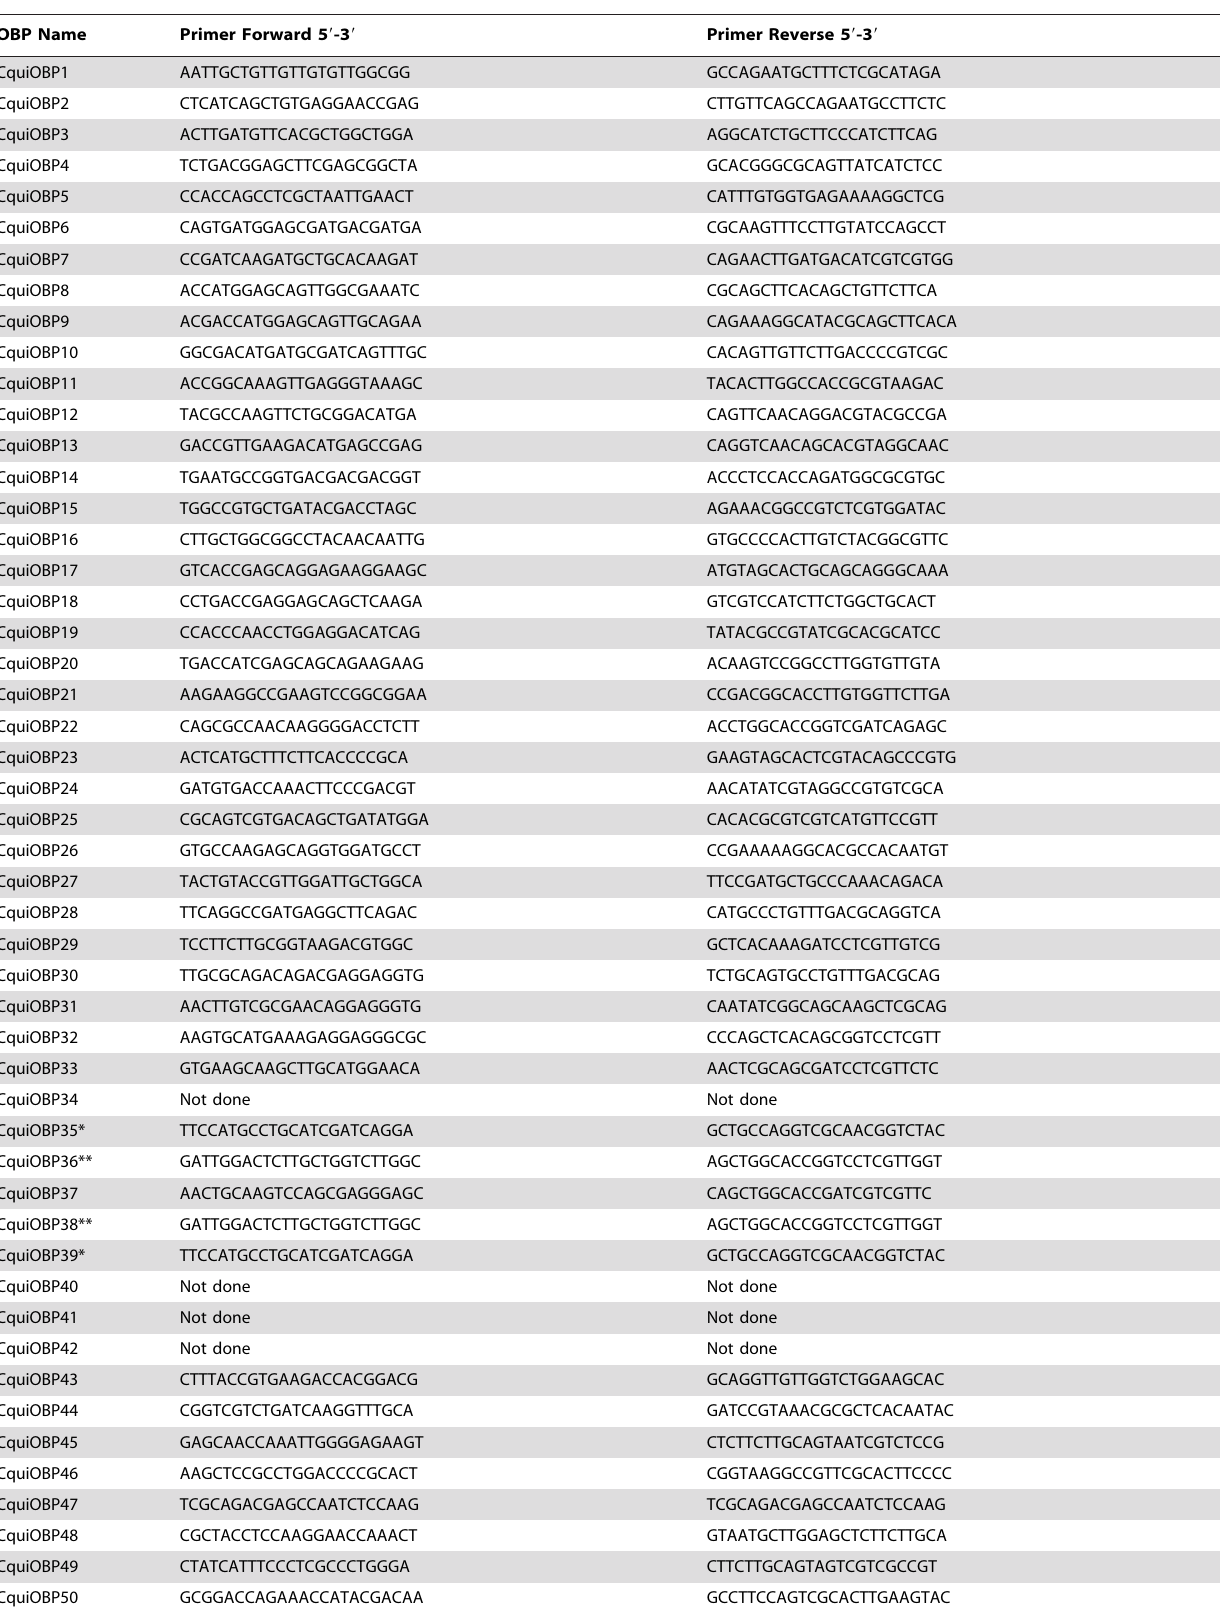
Table 5. List of gene specific primers used in RT-PCR experiments.